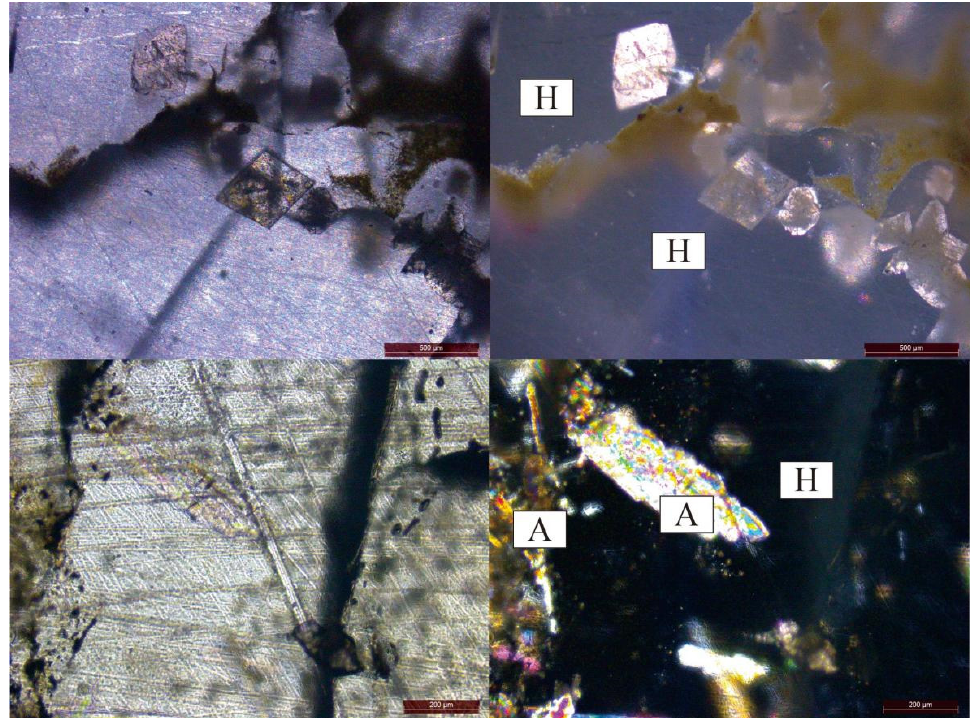
Figure 3. Halite and anhydrite co-existed in well S1 of the Shulu depression. The image on the left is single-polarized light and the image on the right is orthogonal-polarized light. A = anhydrite, H = halite.